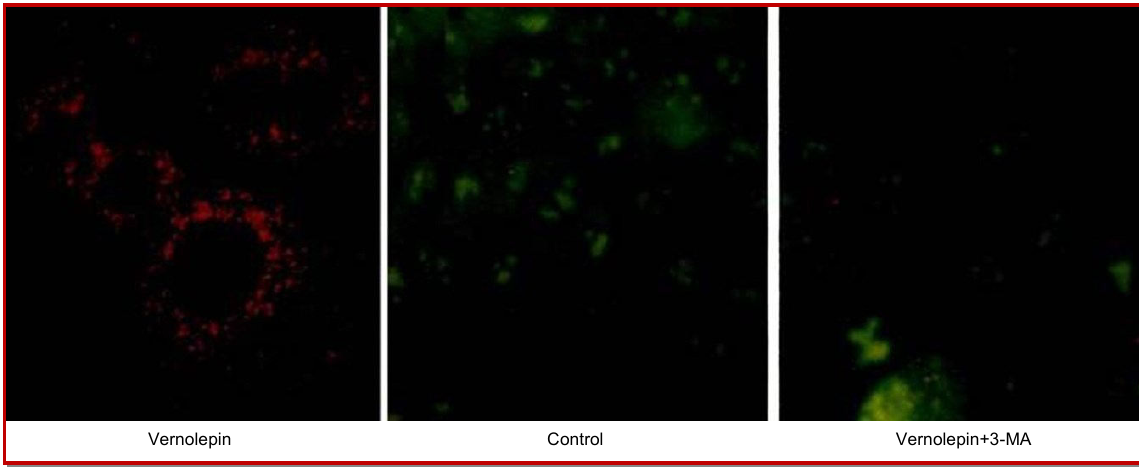
Figure 3 : Accumulation of AVOs induced by vernolepin